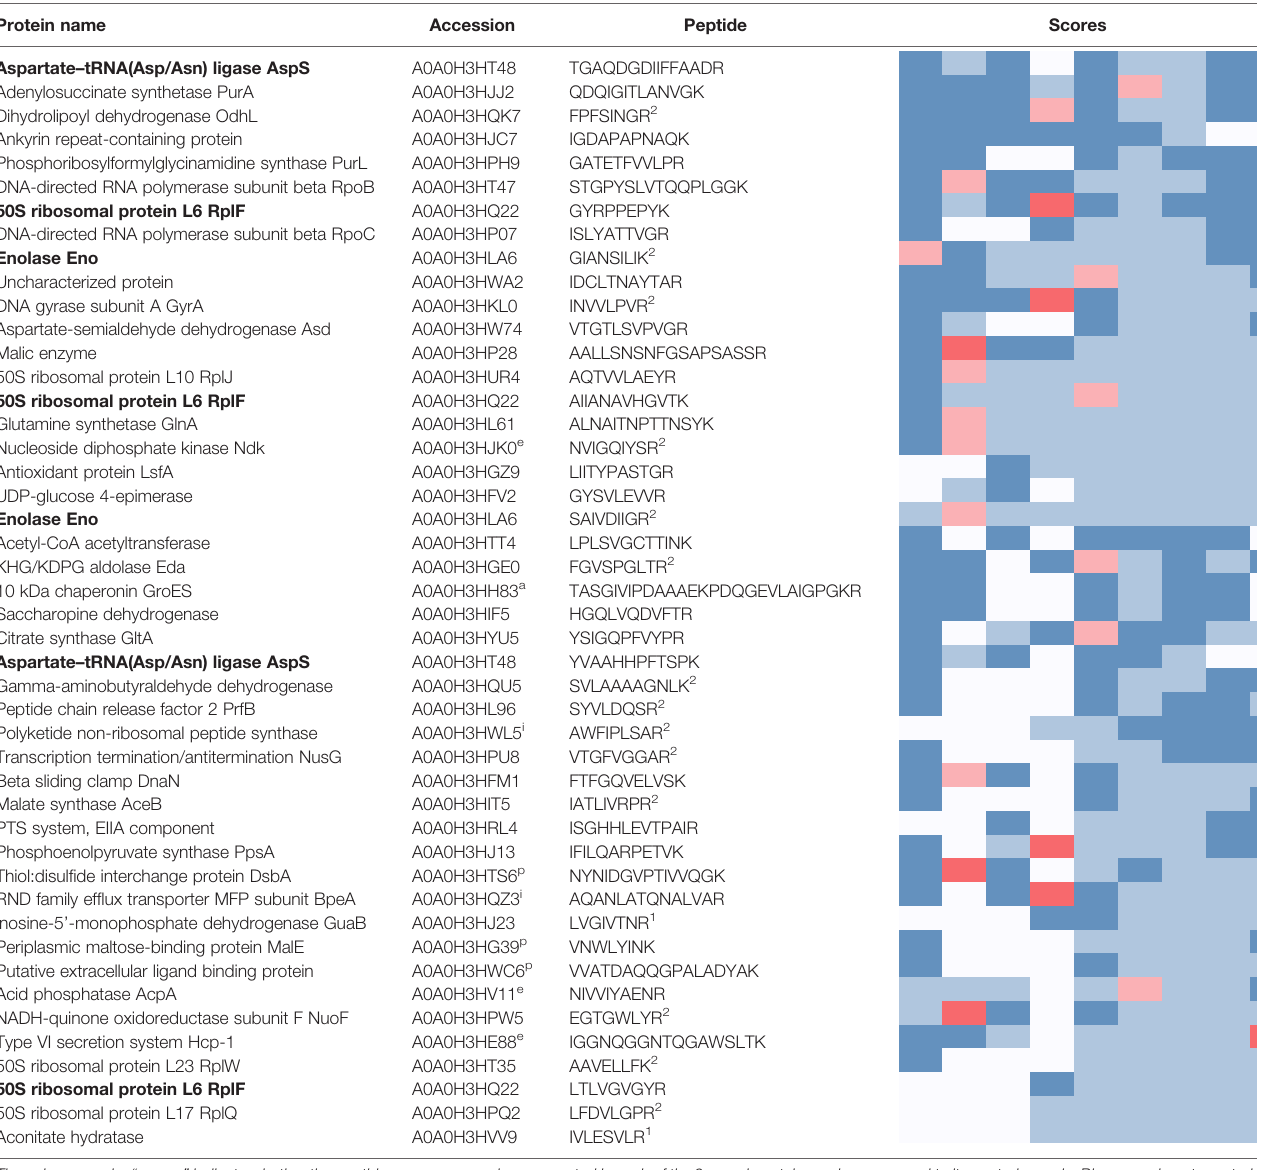
TABLE 2 | List of top scoring immunoreactive peptides identi fi ed for Burkholderia pseudomallei